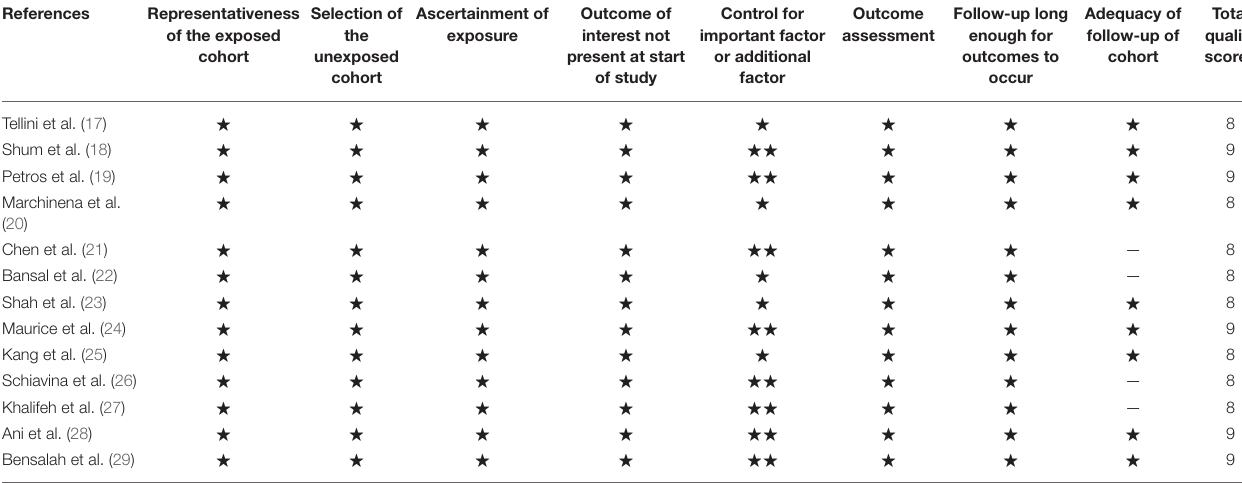
TABLE 2 | Quality assessment based on the NOS of the included studies in this meta- analysis.